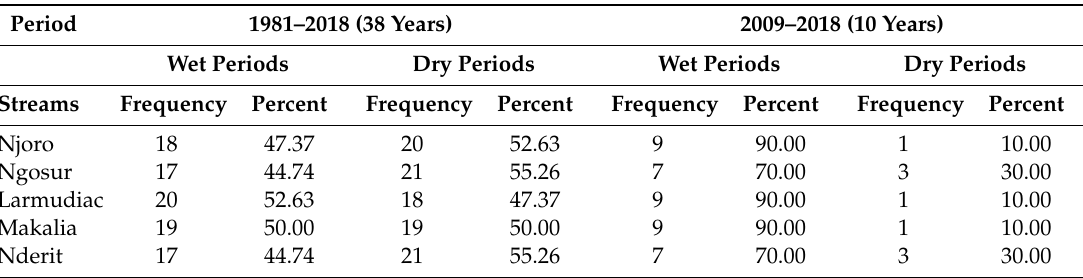
Table 7. Distribution of wet and dry periods for 12-month SDI for Lake Nakuru catchment from 1981 to 2018 and from 2009 to